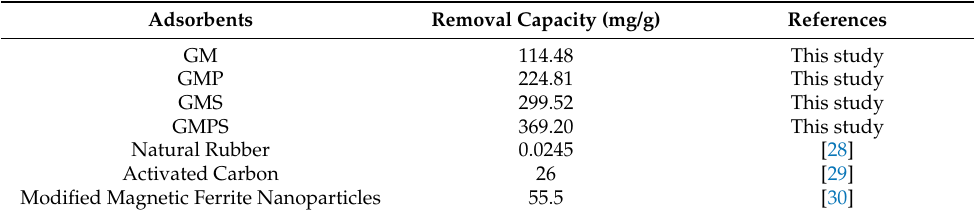
Table 7. Comparison of removal capacity of golden marble with other adsorbents for